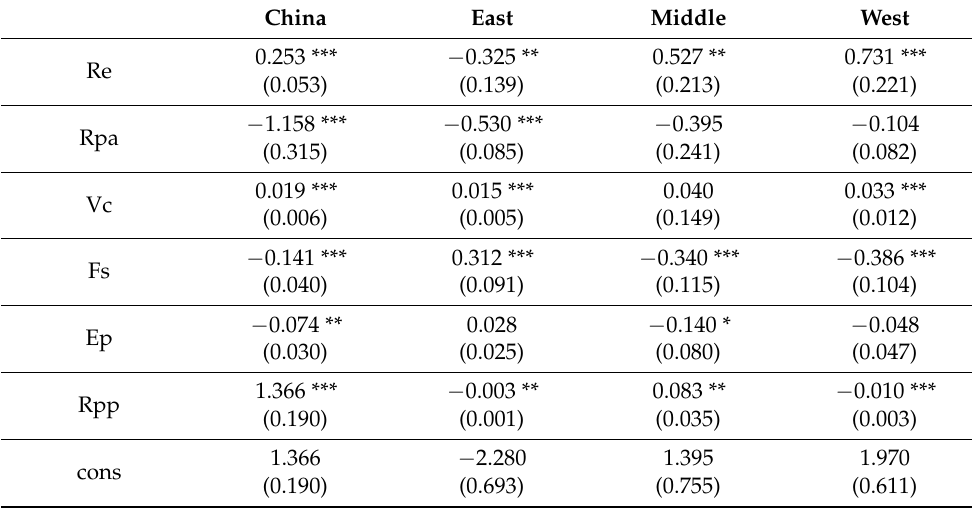
Table 3. The regression results of the Tobit